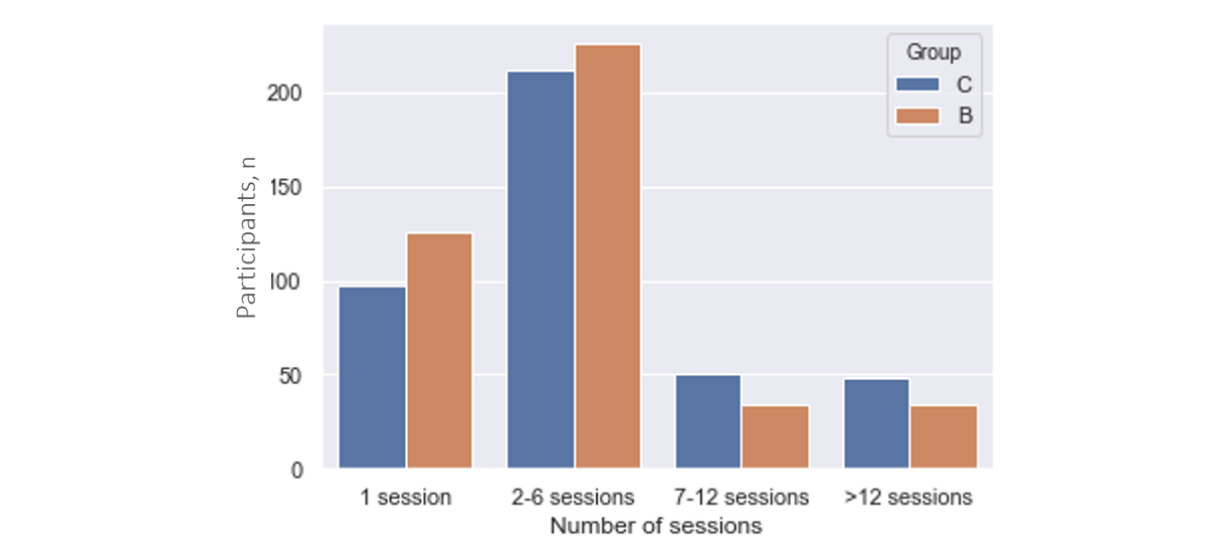
Figure 3. Number of participants completing sessions per group (group B is the platform-only group and group C is the platform plus coaching group) over 24 weeks.